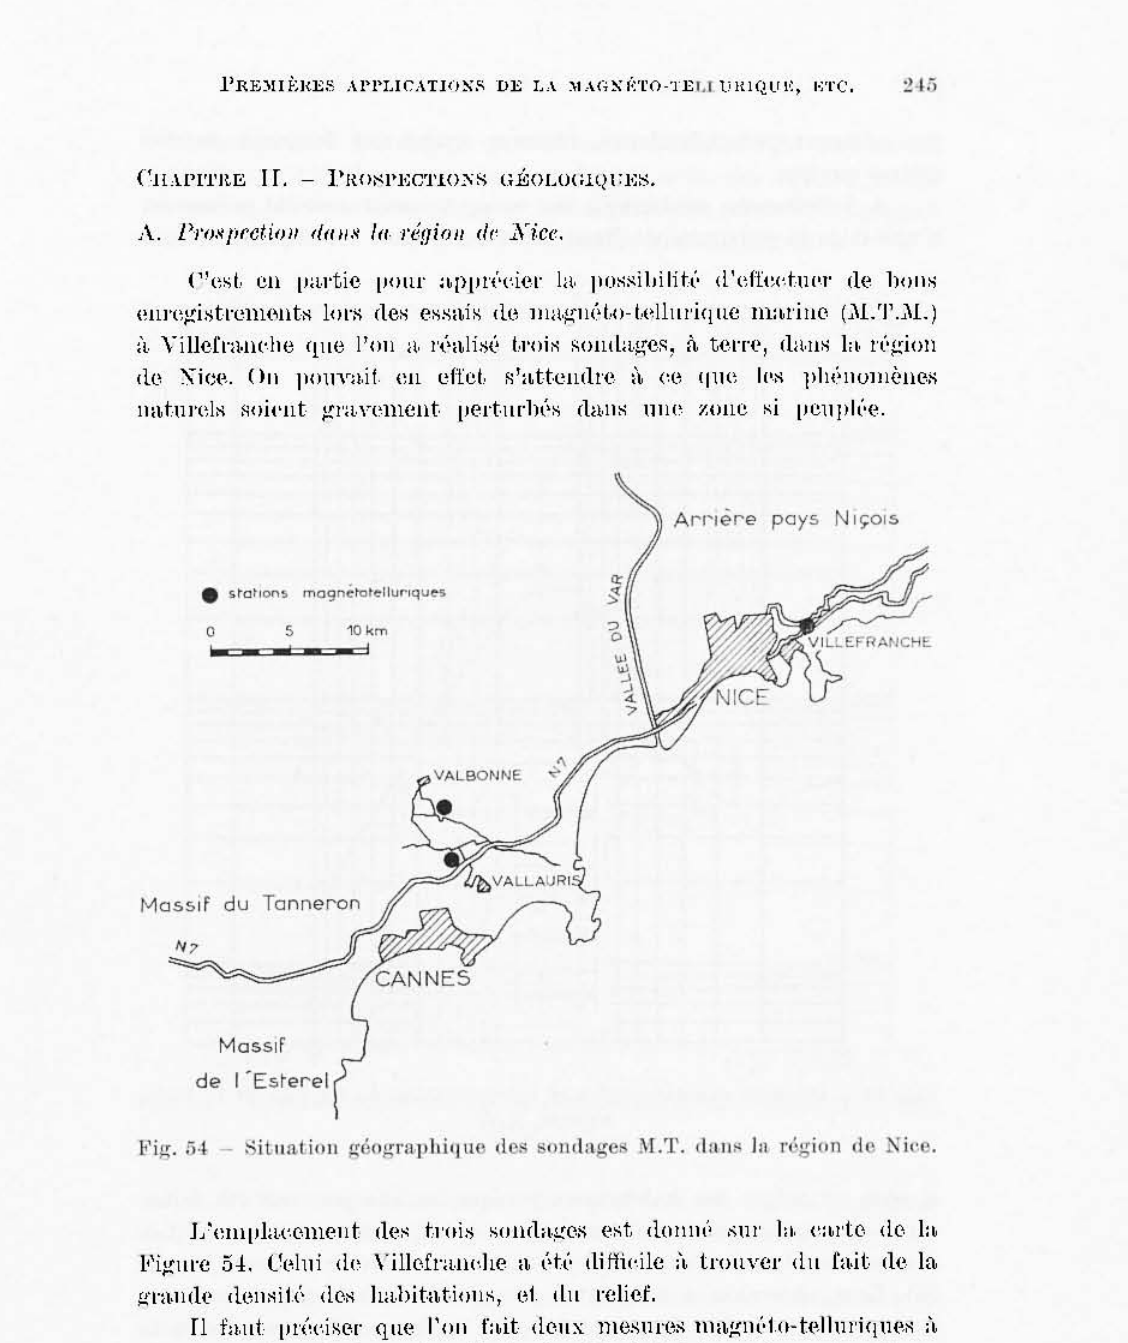
j;elll[lla.(·,eUle11t de~ h'oi.~ sOlldag-e.'{ est. (lo111H" ,~1l1' h ('arte (le la l"igme 54. l\\hd (k \"illefra,lwhe a l>t(· (lifh('ile ;'~ trollVel' (la fait de la ~Ta11de (lellsi1t'· (le.'! ha,hitatiom, el. (la l'elief. fl fu.at [lr{~(',iser qlle l'Oli fait (leax mOS1lres Ilmg-Il(·l.o·tell1ll'iqlles ;'~ ('hl1qlle stH.t.ioll de fa(;ou ;'~ (·akalel' la l'(·sist,iyit.{, dam (leax (lil·(·(·.tioJls. 011 doit. (1011(' hOllvel' Il11 em[llH.e,emellt pOllI' (le1lx li/me,,!